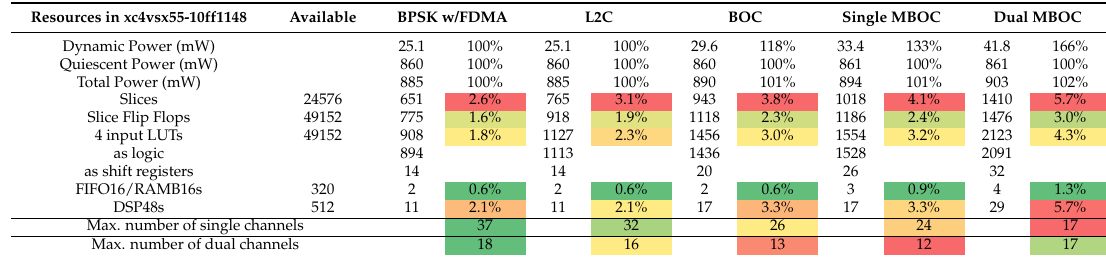
Table 3. Universal Channel Resources for Different Feature Sets.